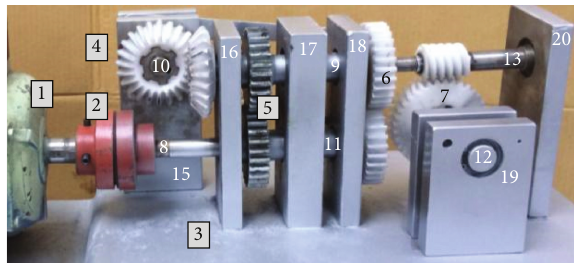
Figure 4: A photograph of the universal test